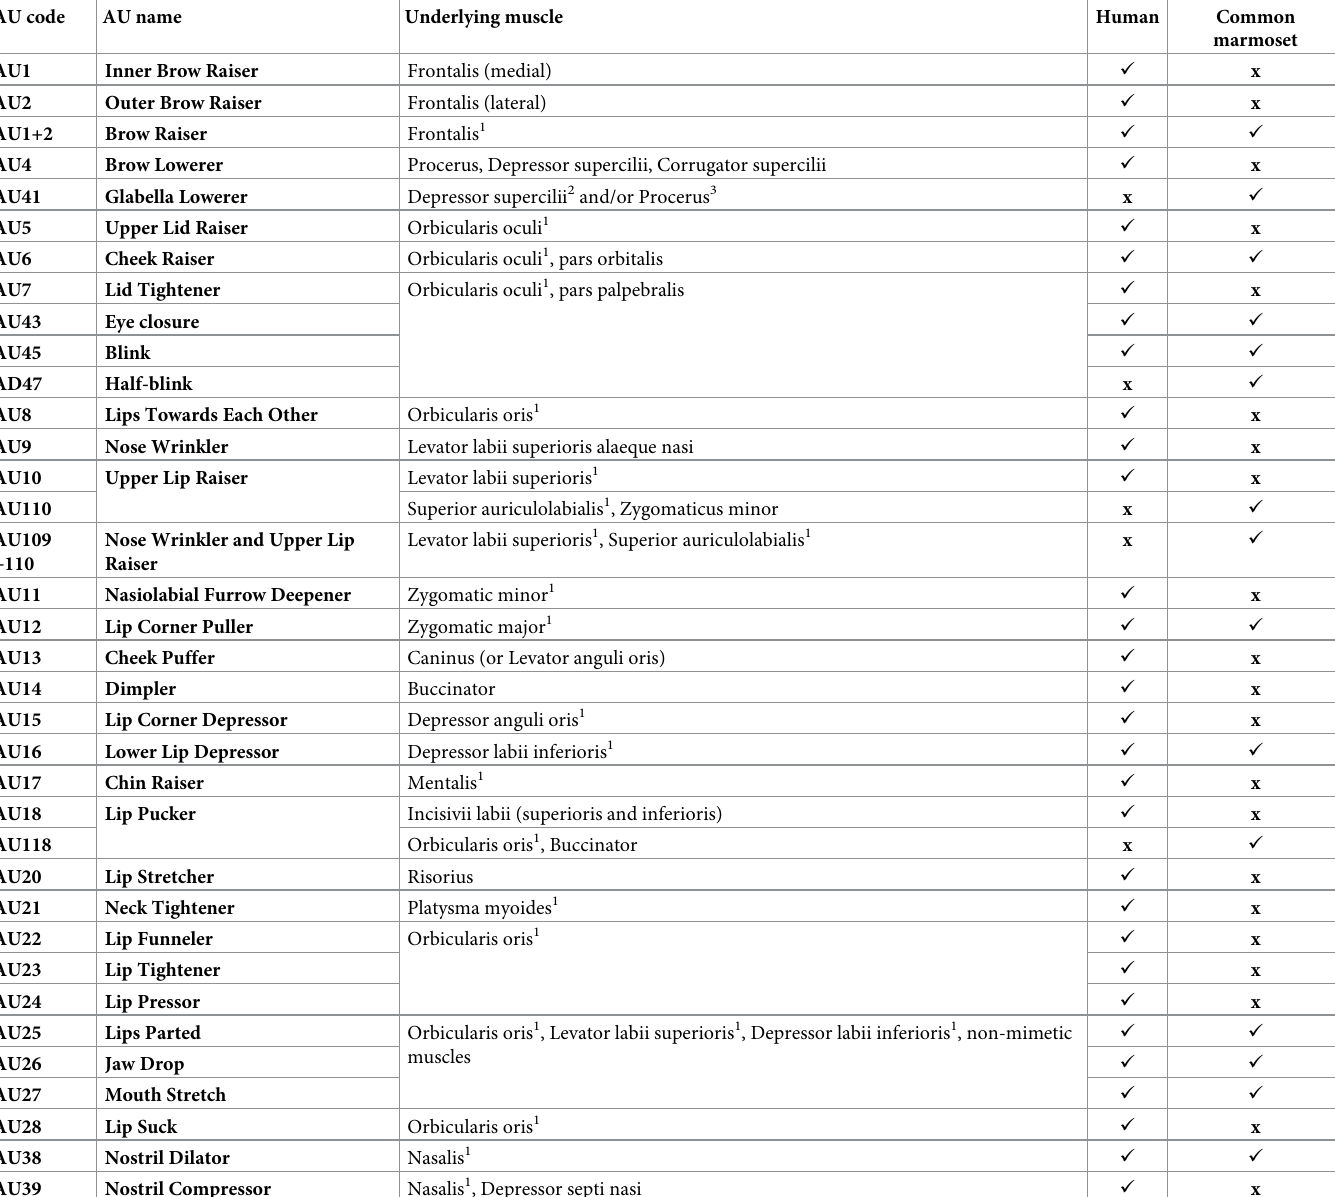
Table 1. Comparison between FACS Action Units (AU) for humans [3] and common marmosets [51, 52, 57] according to underlying musculature. ✓ - present, x —